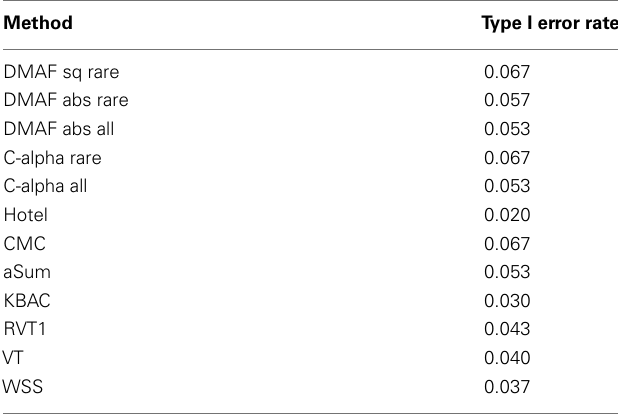
Table 4 |Type I error rates for rare variant association methods.